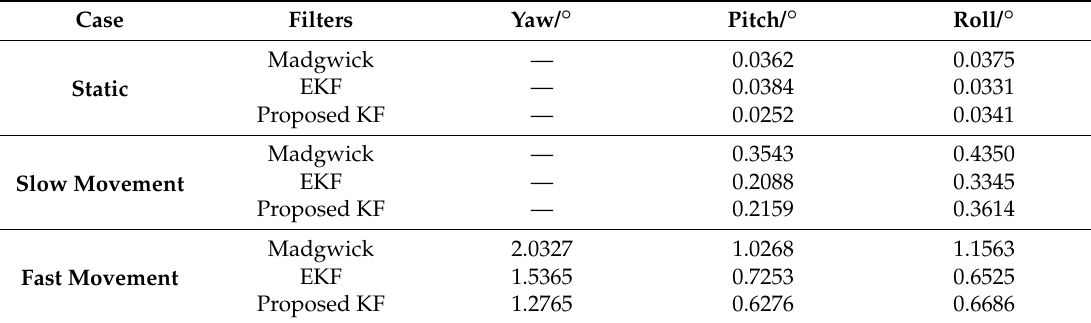
Table 4. RMS (root mean square) errors of the proposed AHRS in various working conditions.